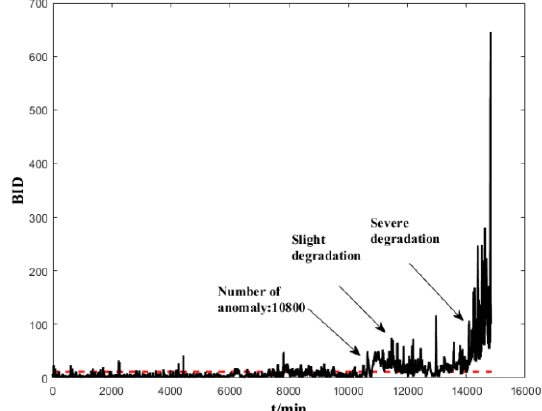
Figure 8. Performance assessment (BID) on the whole life time of B2.